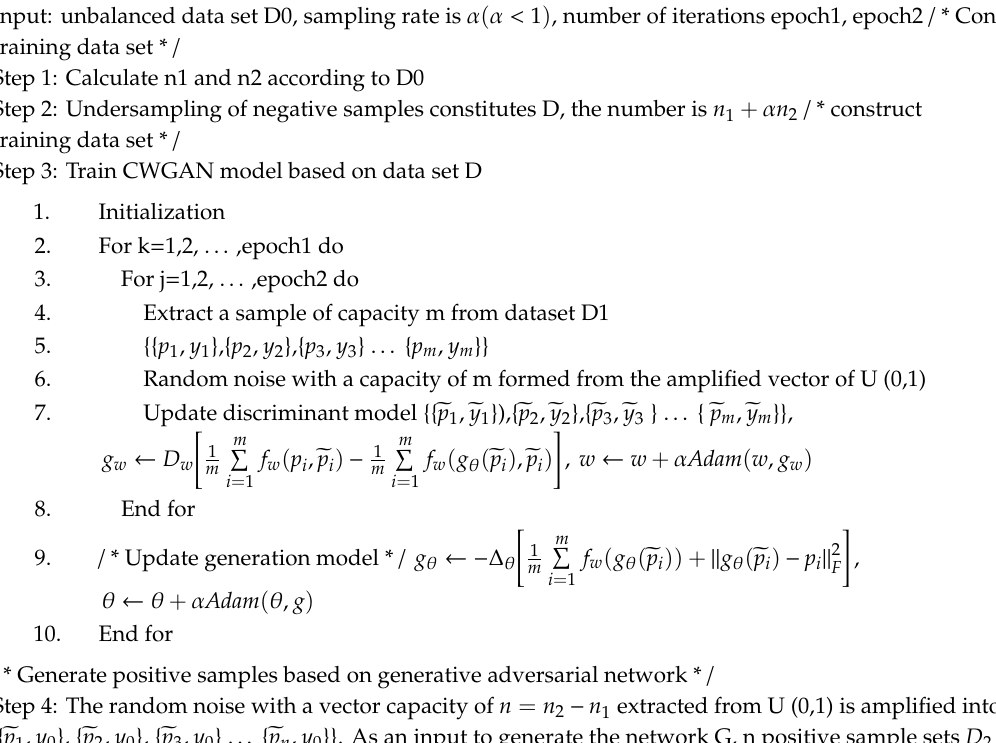
Algorithm 1 CWGAN algorithm for generating steal